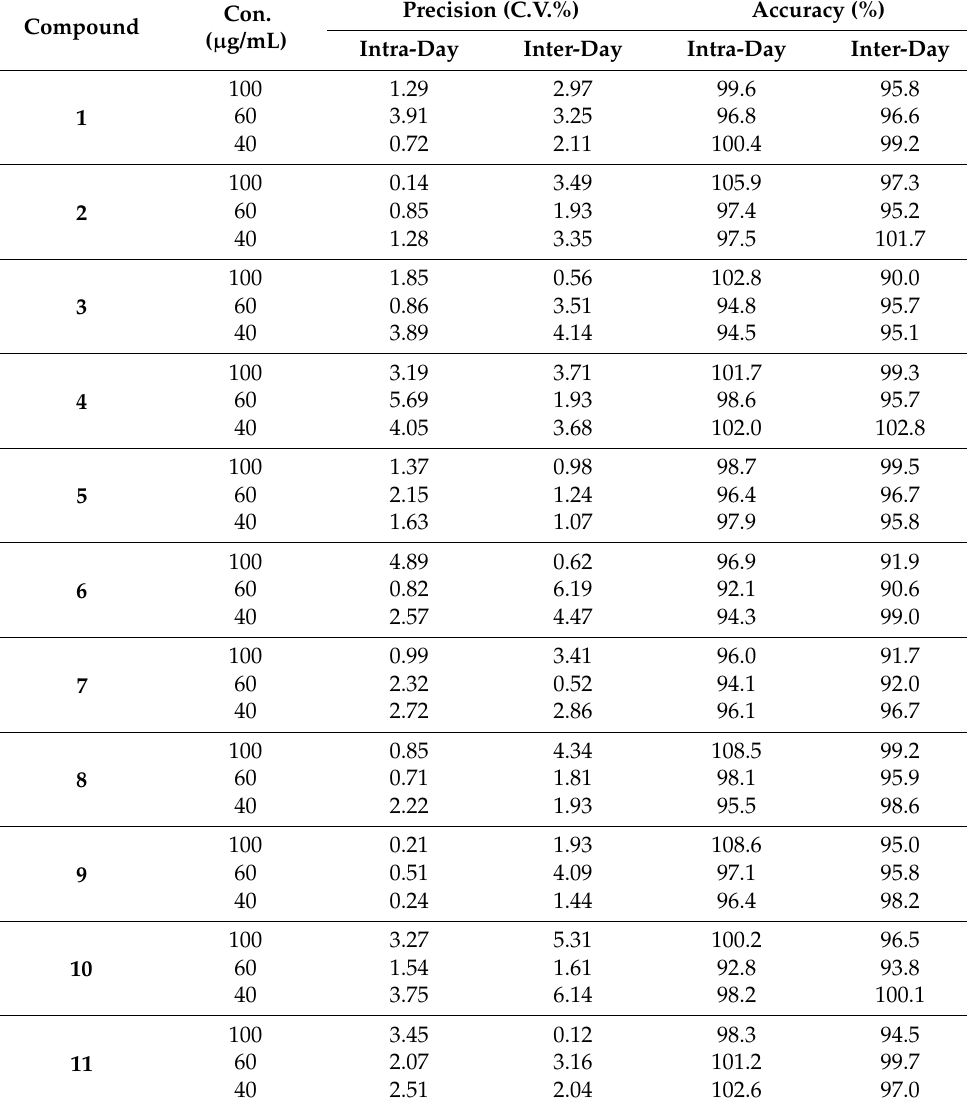
Table 4. Intra-day and inter-day precision and accuracy of compounds 1 – 11 .